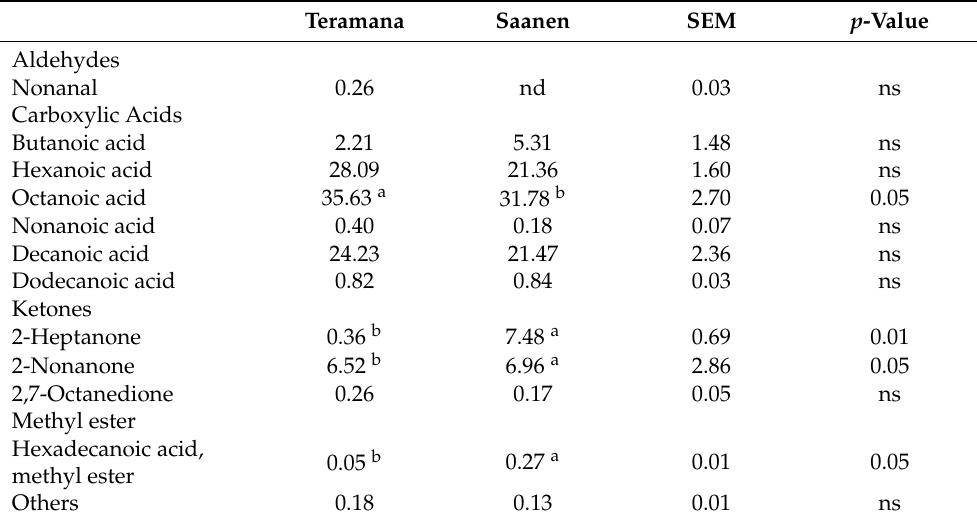
Table 4. The main classes of volatile compounds detected in cheese at 60 (T60) days of ripening were obtained from the milk of Teramana and Saanen breeds. Teramana Saanen SEM p